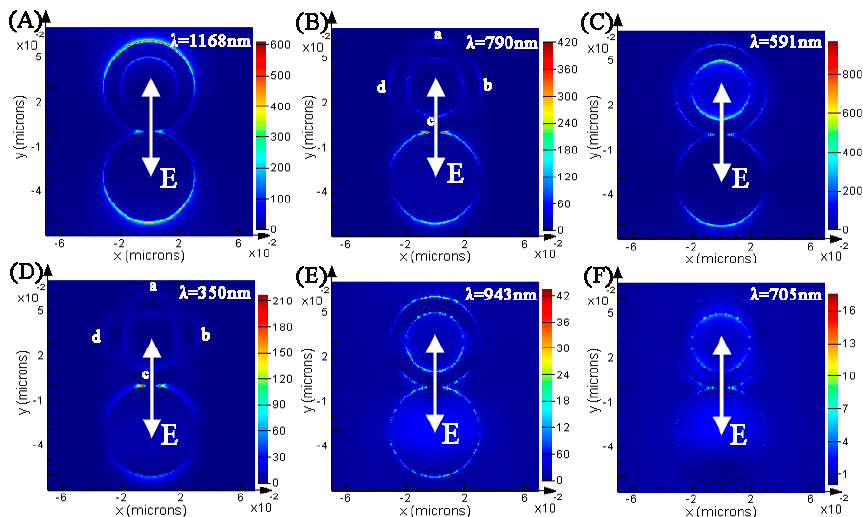
Figure 2. ( A – F ) Calculated electric field |E 2 |/|E 02 | of the Au ring-disk nanostructures at different SPR peaks. H 1 = H 2 = 10 nm, R 1 = 20 nm, R 2 = 30 nm, and R 3 = 30 nm. The color bars in the logarithmic